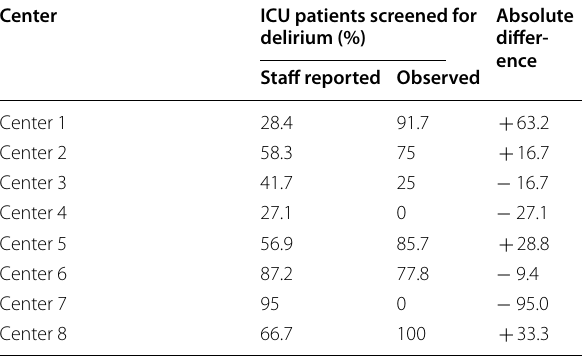
Table 2. Perceived vs. observed delirium screening practices in 8 par- ticipating centers Center ICU patients screened for delirium